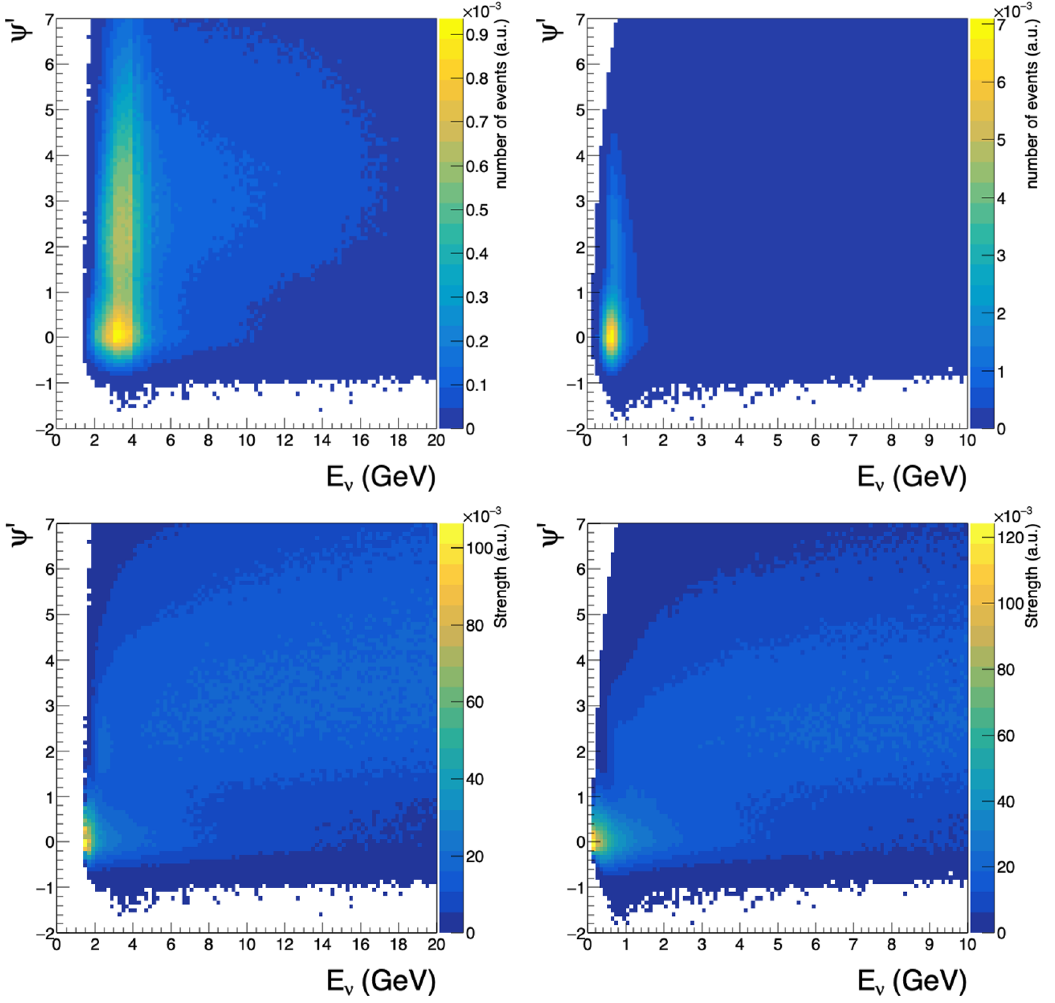
Figure 20 . Top: distribution of the scaling variable ψ 0 versus the neutrino energy for the CC inclusive MINERvA (left) and T2K (right) experiments, as predicted by NEUT. Bottom: the distributions shown in the upper panels, but normalised to unity by column